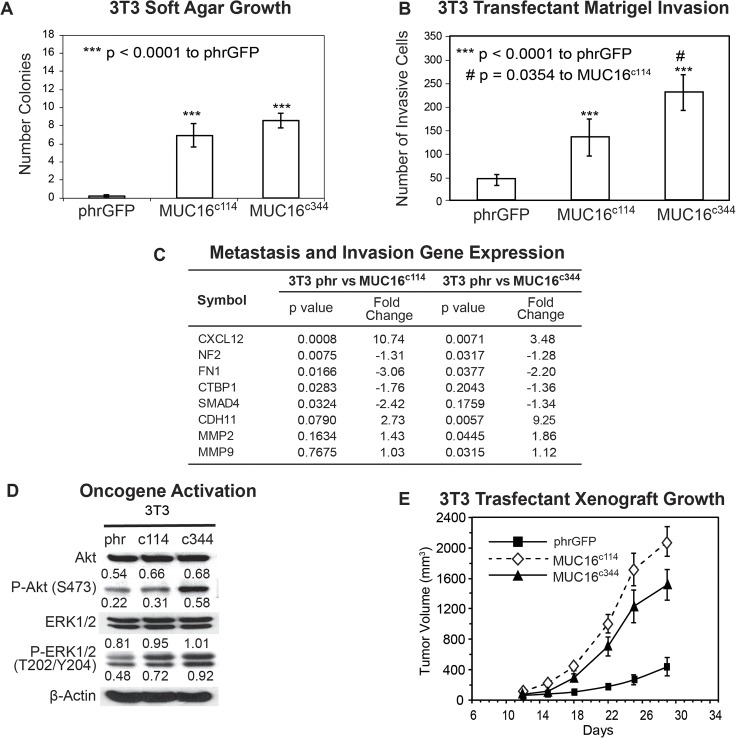
Effect of MUC16 in 3T3 cells.A) Soft agar growth of 3T3 transfectants in 60 mm dishes. After 14 days, colonies were counted and plotted. The data shown in the table represent one of three similar experiments (*** p < 0.0001) compared to the phrGFP control vector; B) Matrigel invasion assay for 3T3 cell lines following stable transfections with either the phrGFP control vector, MUC16c114-phrGFP or MUC16c344 phrGFP carboxy-terminal constructs. Each assay was performed two or more times in triplicate and counted by hand. Both MUC16c114 3T3 and MUC16c344 3T3 cell lines were significantly more invasive (*** p<0.0001) compared to the phrGFP 3T3 vector control, and the MUC16c344 cell line is significantly more invasive than the MUC16c114 cell line (# p = 0.0354). C) Expression of metastasis and invasion genes induced by MUC16c114 and MUC16c344 expression. A SuperArray panel of 80 invasion/metastasis gene transcripts was examined for MUC16-positive and vector only cell lines. The expression of selected chemotactic, adhesion, and invasion transcripts was measured in 3T3 MUC16c114 or 3T3-MUC16c344 cell lines (each of three triplicates was examined in duplicate and compared to the phr vector only controls by chi square testing). The p value for each transcript, adjusted for repeated measures, is shown in the table. All genes with changes at the corrected p<0.05 or below level are included. D) Transfected 3T3 cells were examined for activation of the ERK/AKT signaling pathways compared to the vector only controls. Phosphorylation of ERK1/2 (pT202/Y204) and AKT (S473) was increased following MUC16c114 and MUC16c344 constructs, compared to the phrGFP vector. Activation of both pathways was seen in each of the cell lines. β-Actin normalized densitometry quantification values are shown below each Western blot band. E) MUC16 transfectant tumor growth in athymic nude mice. Two million tumor cells were introduced into the flank of 15 nu/nu mice, and the mice were observed for tumor formation. Tumors were measured by calipers twice weekly. The differences in mean tumor volume were significantly greater for mice bearing MUC16-positive tumors (both lines p<0.0001 compared to the phrGFP control vector).